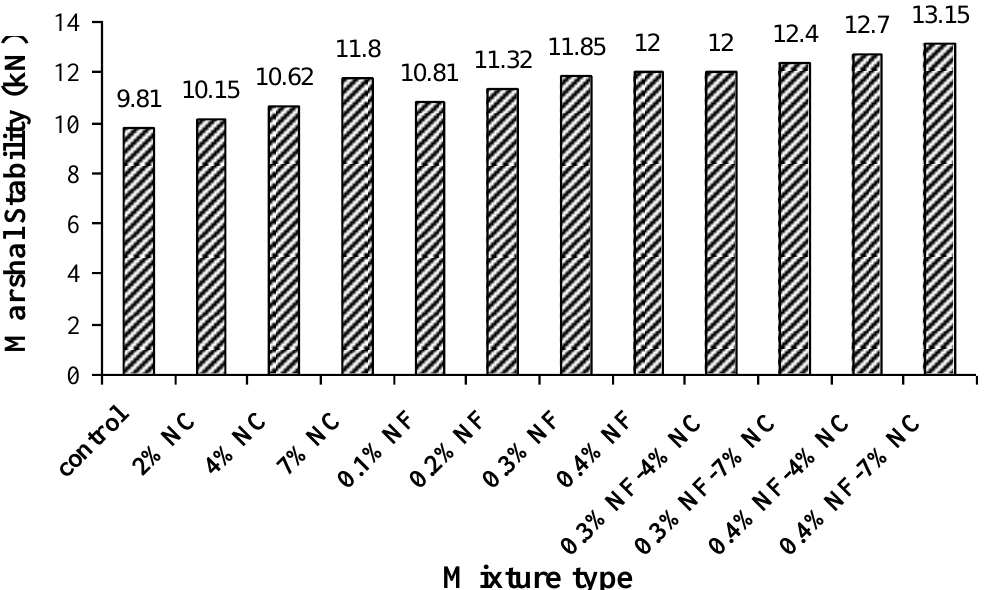
Fig. 3. Marshall Stability of